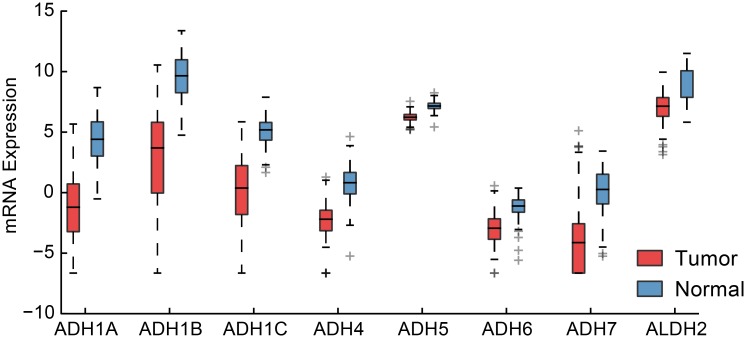
Differential expression of alcohol dehydrogenase family of genes.Shown here for TCGA breast cancer dataset as a representative cohort. Also shown is ALDH2 which is the major enzyme responsible for breaking down acetaldehyde, the primary intermediate product of alcohol metabolism.